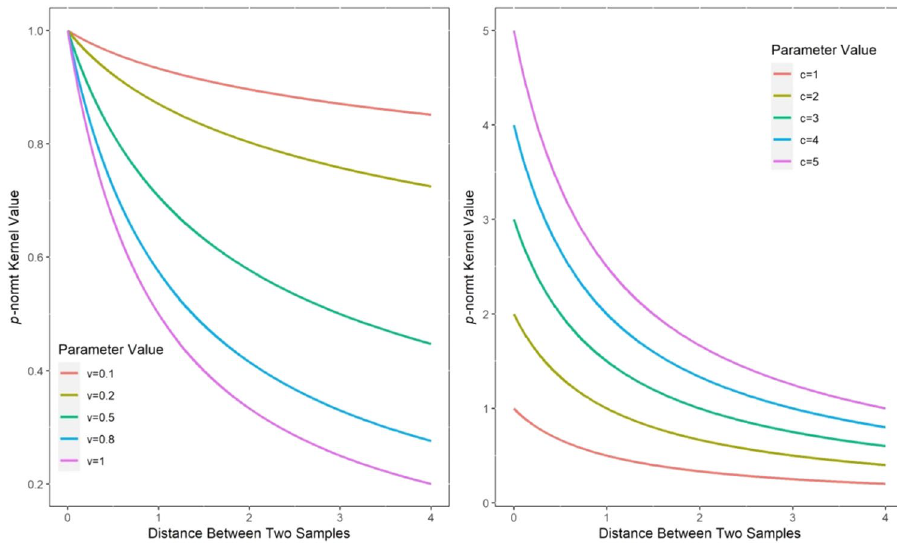
Figure 1. p -norm distance t-kernel value under different scale